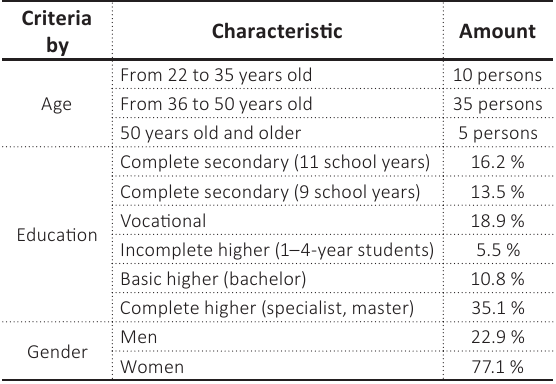
Table 1. The distribution the target groups of IDPs: the sociological